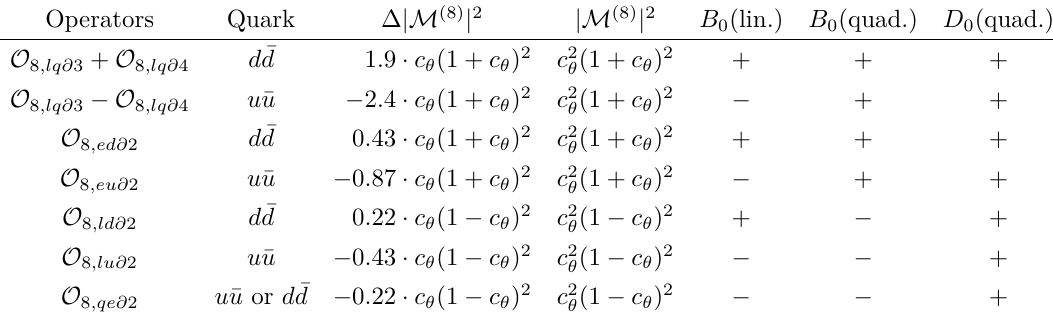
Table 2 . Schematic angular dependence of the linear and quadratic contributions of the dim-8 operators to q ¯ q → ‘ − ‘ + scattering in the the induced B 0 and D 0 after integrating with the spherical harmonic functions Y 0 “Quark” column denotes quark-anti quark channel(s) mediated by each